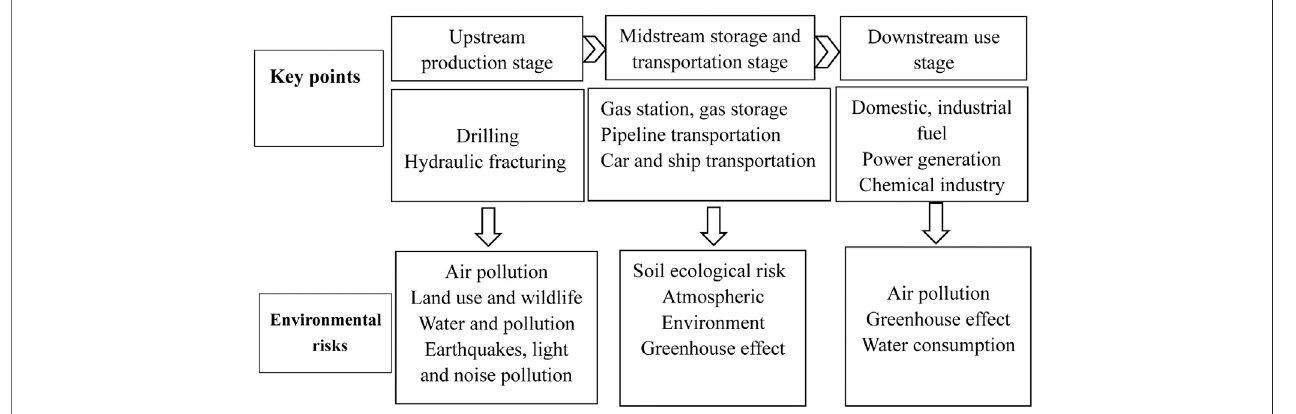
FIGURE 1 | Environmental risks from natural gas utilization throughout the industry chain.